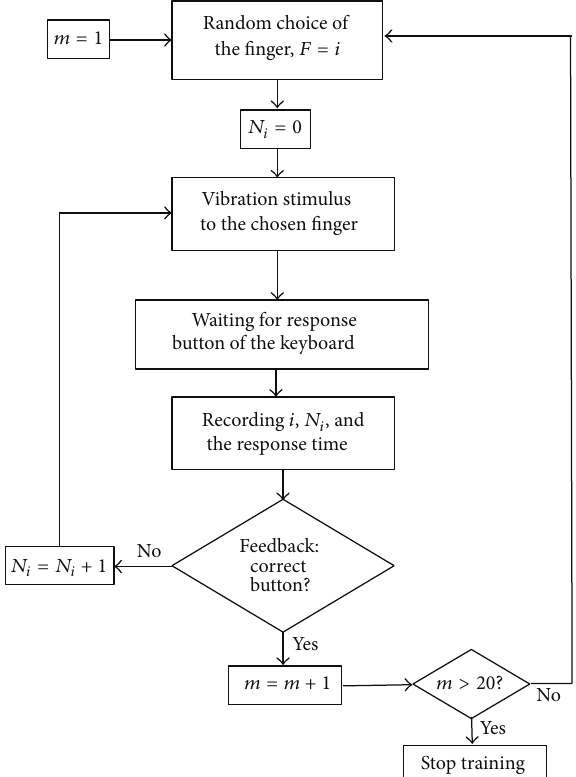
Figure 2: Training procedure ( 𝑚 : the number of trials, 𝑖 : the finger number, and 𝑁 𝑖 : the number of errors for the finger 𝑖